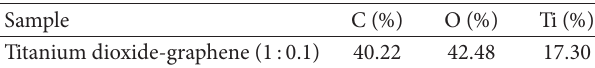
Titanium dioxide-graphene